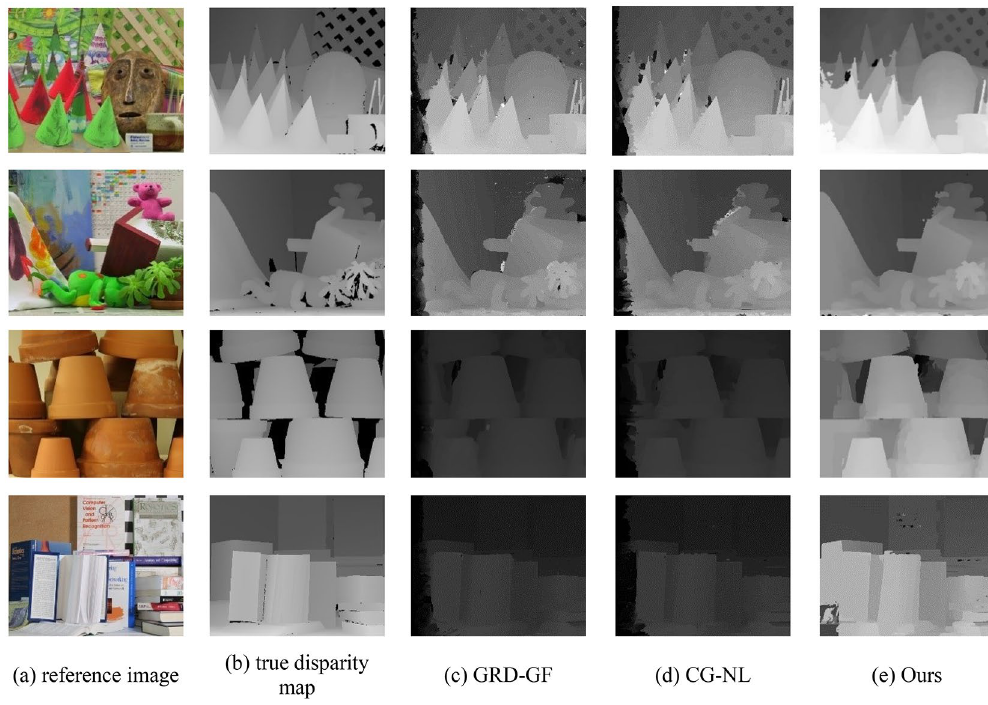
Figure 8. Disparity maps generated by different algorithms.